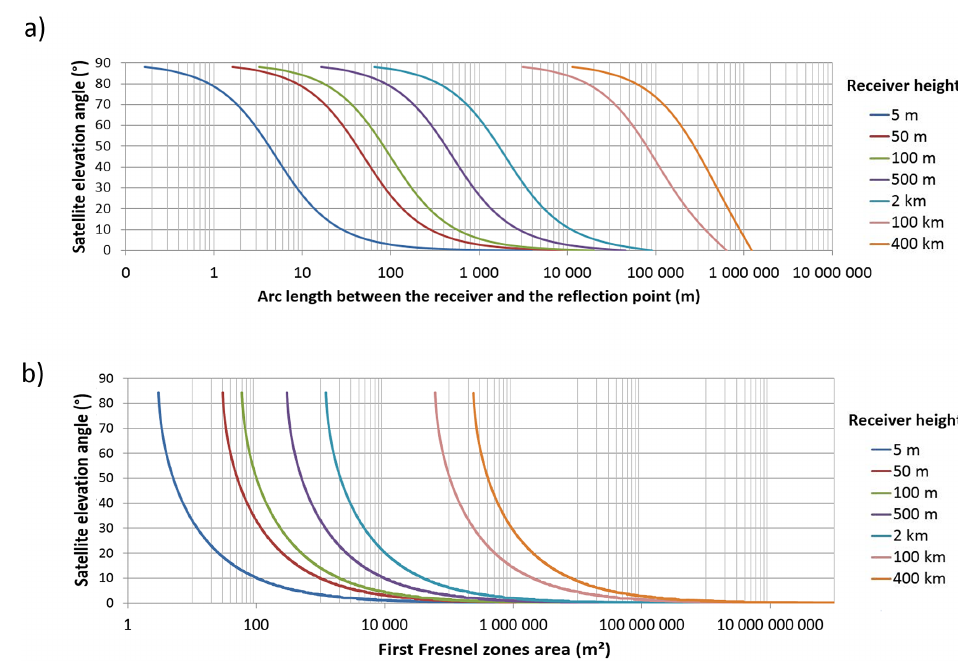
Figure 9. Variation of the distance between the receiver and the specular reflection point (a) and the first Fresnel zone area (b) as a function of the satellite elevation angle, for different receiver heights.